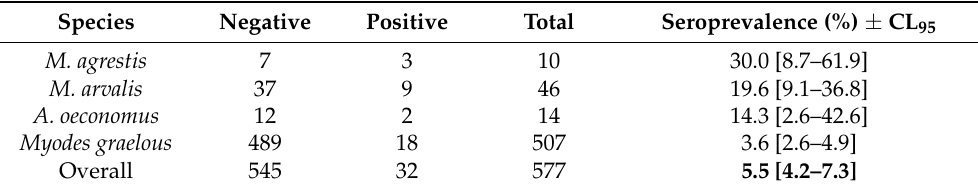
Table 1. Seroprevalence of T. gondii in four rodent species in Poland. Seroprevalence is given in percentages with 95% CL in